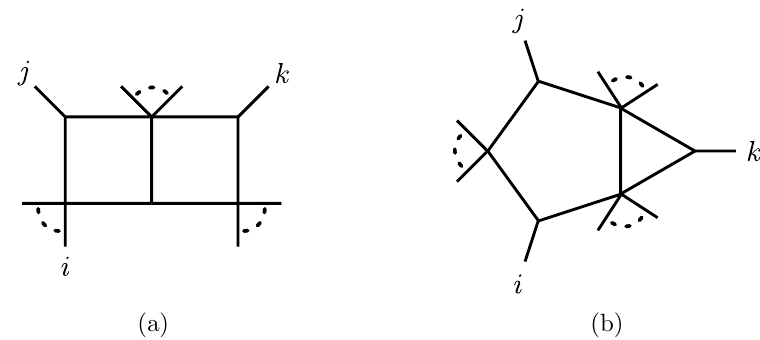
Figure 6. The Landau diagrams showing the seven cut conditions satis(cid:12)ed by (cid:12)gures 5a and 5b,